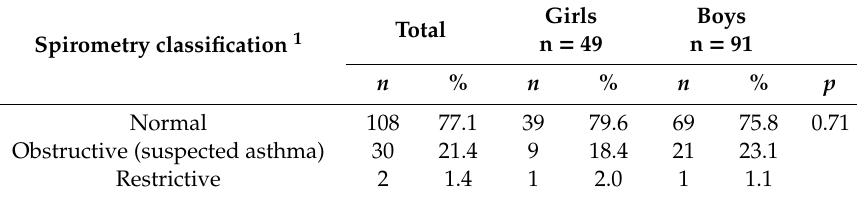
Table 4. Spirometry, hired Latinx child farmworkers in North Carolina (n = 140).